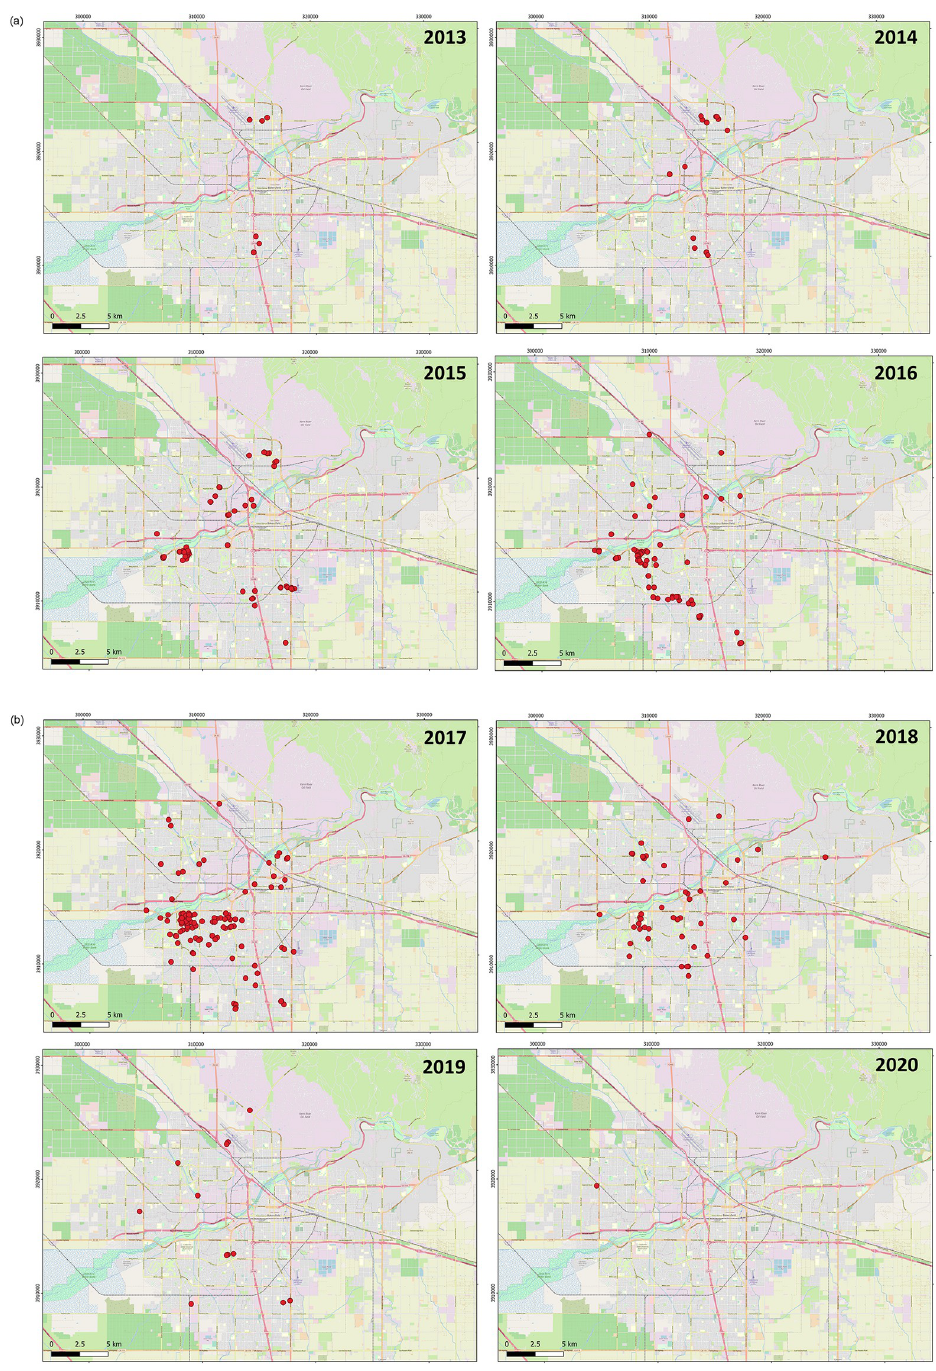
Fig 2. Annual locations of sarcoptic mange cases during an epidemic among San Joaquin kit foxes in Bakersfield, California from 2013–2020. Base map and data from OpenStreetMap and OpenStreetMap